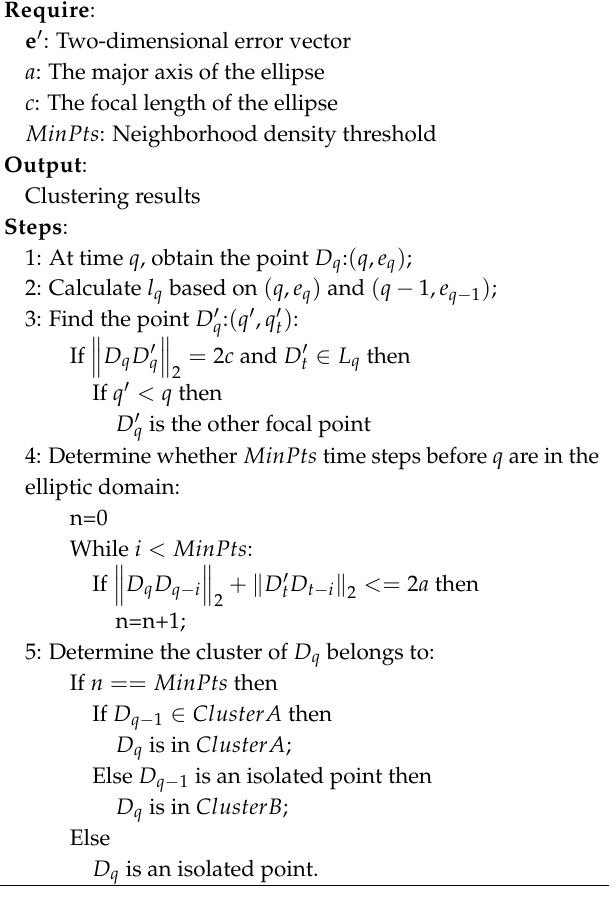
Algorithm 1 The novel unsupervised clustering algorithm